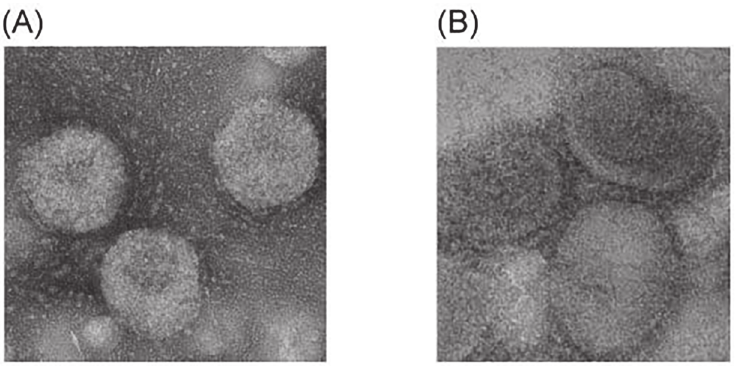
Fig 1. Electron micrograph (100,000×) of MDCK cell-derived (A) and egg-derived (B) influenza H7N9 virus particles after purification. Egg-derived influenza H7N9 virus particles were obtained from the US FDA as standard antigens of SRD assay.